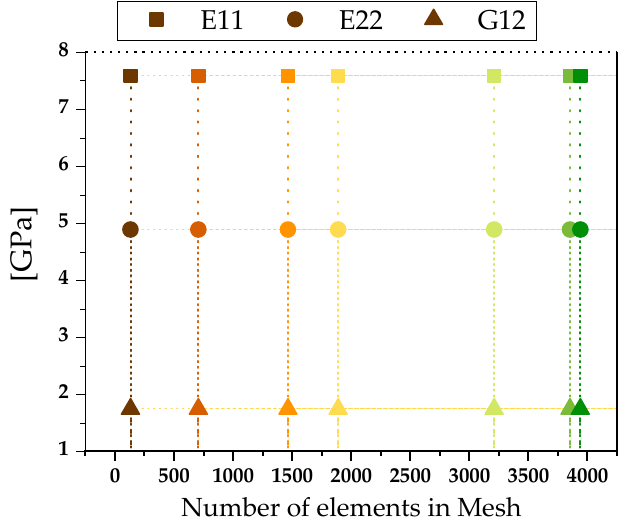
Figure 6. Mesh convergence analysis for finite elements of: E 11 , E 22 and G 12 at 15% of volume fraction of natural fiber.